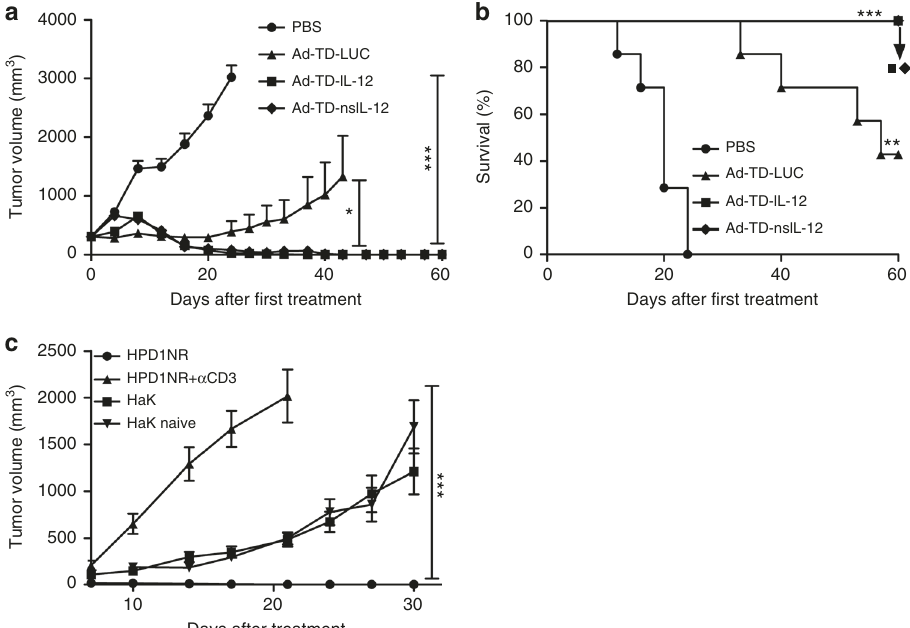
Fig. 4 Ad-TD-nsIL-12 is an effective treatment for subcutaneous hamster PaCa. 2 × 10 6 HPD1NR cells were seeded into the right fl ank of Syrian hamsters. When tumor volumes reached 300 mm 3 , seven hamsters per group were each injected i.t. with 100 µ l PBS, 1 × 10 9 PFU Ad-TD-LUC or Ad-TD-nsIL-12/IL-12 on days 0, 2, 4, 6, 8, and 10. a Mean tumor sizes and SEM are shown for each group and compared using a one-way ANOVA with post hoc Tukey ’ s Multiple Comparison Test. * p < 0.05, *** p < 0.001. b Kaplan – Meier survival curves were generated and a log-rank (Mantel – Cox) test used to analyze signi fi cance. ** p < 0.01, *** p < 0.001. Treatment with both Ad-TD-IL-12 and Ad-TD-nsIL-12 resulted in 100% survival in this model. c Hamsters that had cleared tumors after i.t treatment with Ad-TD-nsIL-12 during ef fi cacy experiments were re-challenged 4 weeks later in the opposite fl ank with 4 × 10 6 HPD1NR or 5 × 10 6 HaK cells, or were injected i.p with anti-CD3 mAb (500 μ g/injection) on the day before re-challenge with HPD1NR cells. In parallel, naive hamsters were injected with 5 × 10 6 HaK cells at the same sites and tumor growth measured and analyzed using a one-way ANOVA with post hoc Tukey ’ s Multiple Comparison Test. *** p <